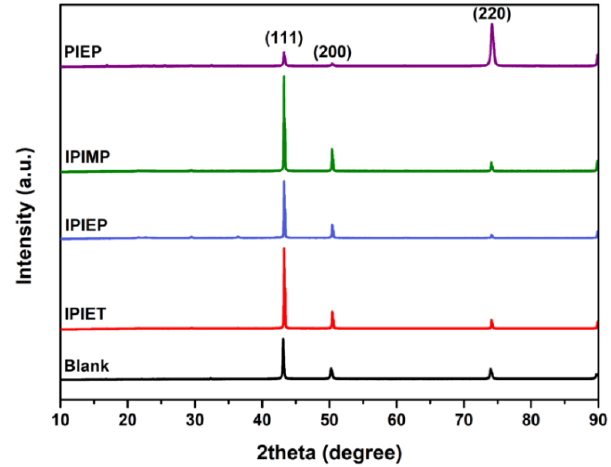
Figure 5. XRD patterns of the electroplated copper film obtained in the base electrolyte without or with 5 mg/L oligomers. Table 1. Energy values of molecular orbital and bandgap energy ( ∆ Eg) of oligomers. Oligomer E HOMO (eV) E LUMO (eV) ∆ Eg (eV) PIEP − 5.53 − 0.04 5.49 IPIET − 3.73 − 1.36 2.37 IPIMP − 2.94